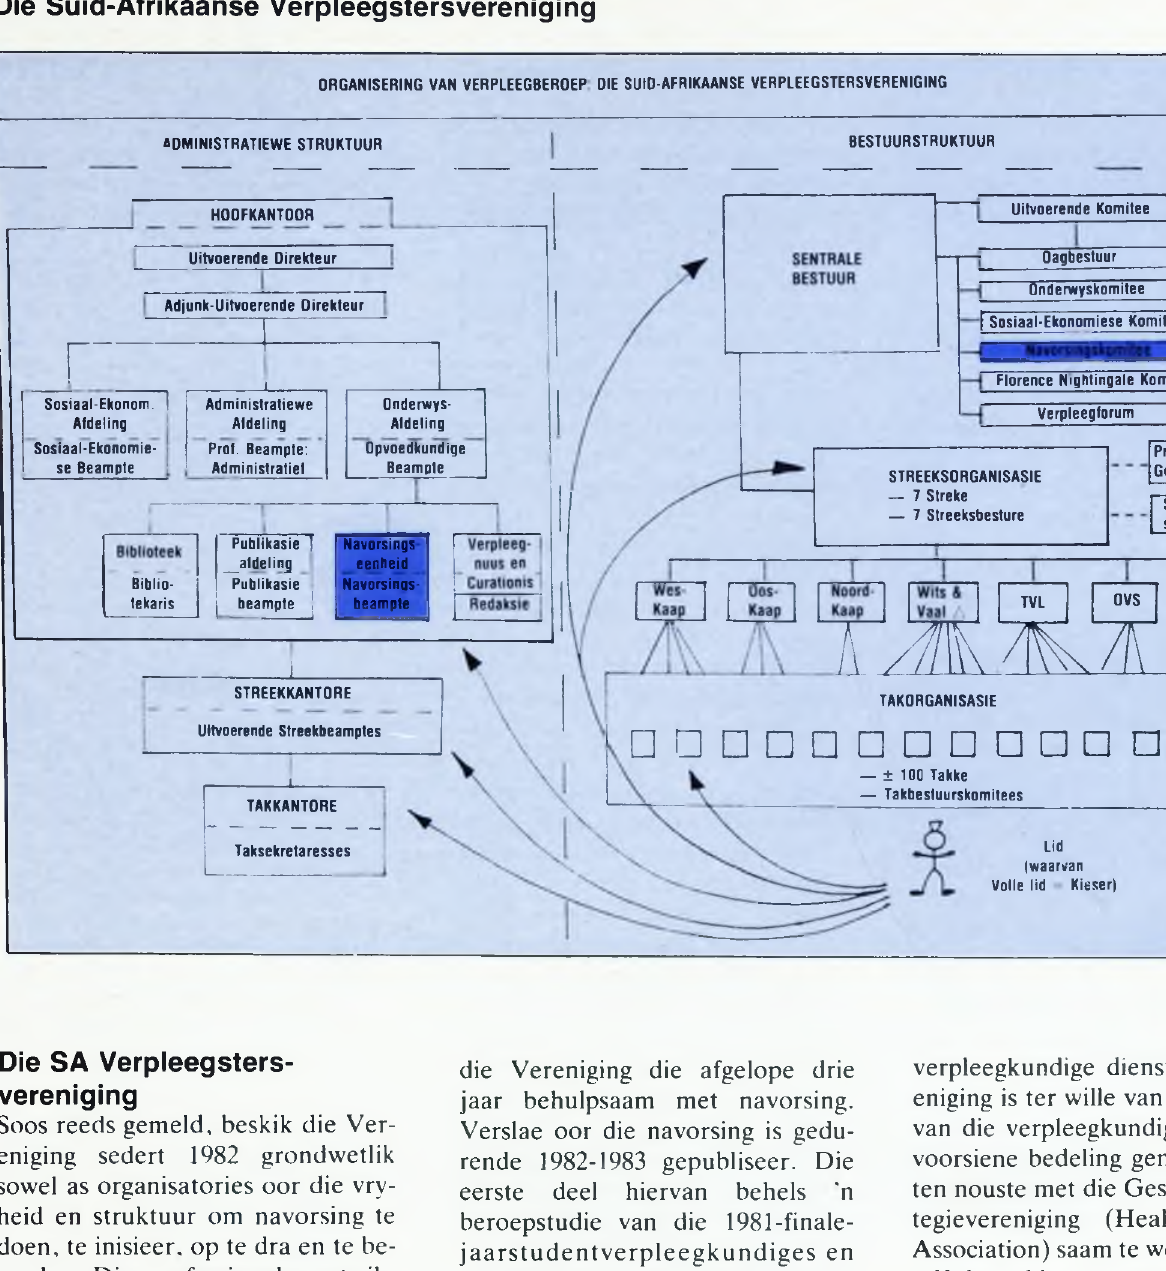
Diagram 6 Organisering van die